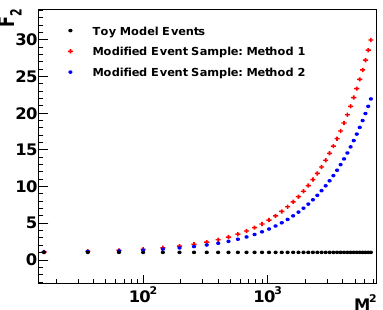
Figure 1: F vs M 2 , depicting sensitivity of analysis technique to gauge bin-to-bin 2 fluctuations in the ToyModel events.